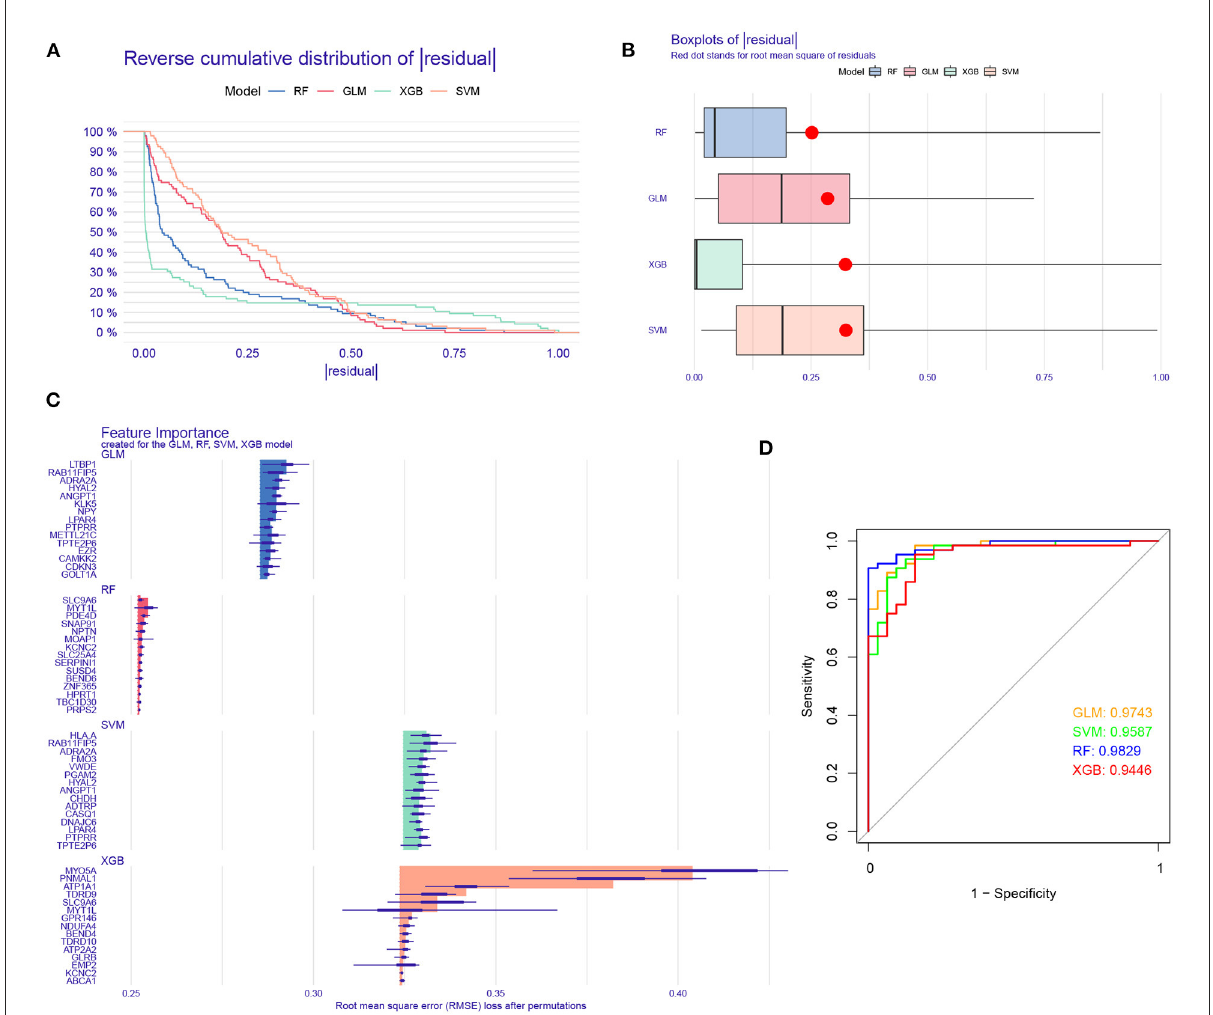
FIGURE8 Construction and evaluation of RF, SVM, GLM, and XGB machine models. (A) Cumulative residual distribution of each machine learning model. (B) Boxplots showed the residuals of each machine learning model. Red dot represented the root mean square of residuals (RMSE). (C) The important features in RF, SVM, GLM, and XGB machine models. (D) ROC analysis of four machine learning models based on 5-fold cross-validation in the testing